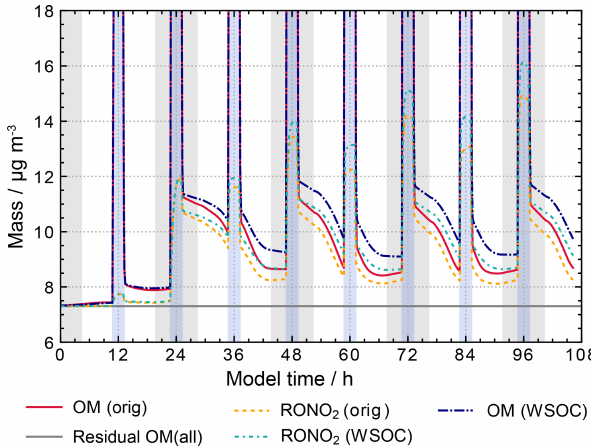
Figure 13. Processing of the organic mass fraction in the sensitiv- ity runs investigating the influence of parameterizations for WSOC chemistry and HULIS chemistry on aqueous-phase chemistry and composition using the same conditions as in the base scenario with additional reactions given in Table 4. Cloud passages are shaded blue and night-time periods are shaded grey. Scenario names used in the legend are explained in Appendix